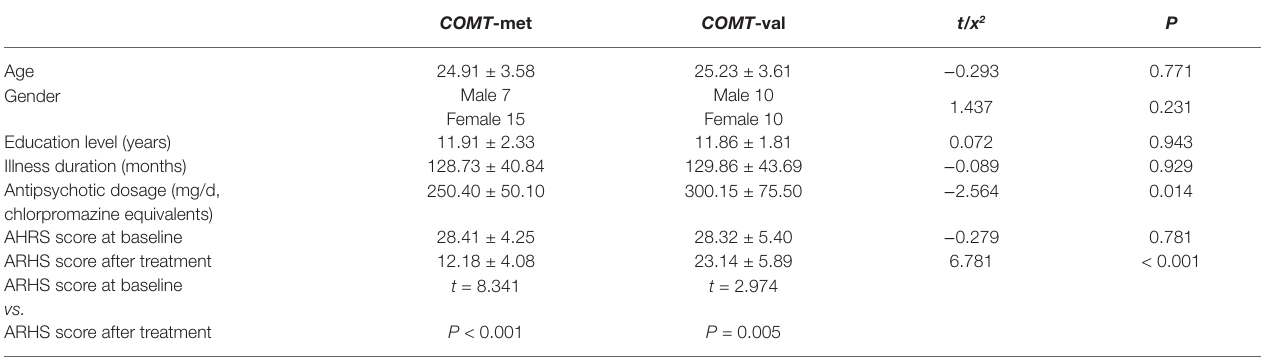
TABLE 1 | Sociodemographic and clinical